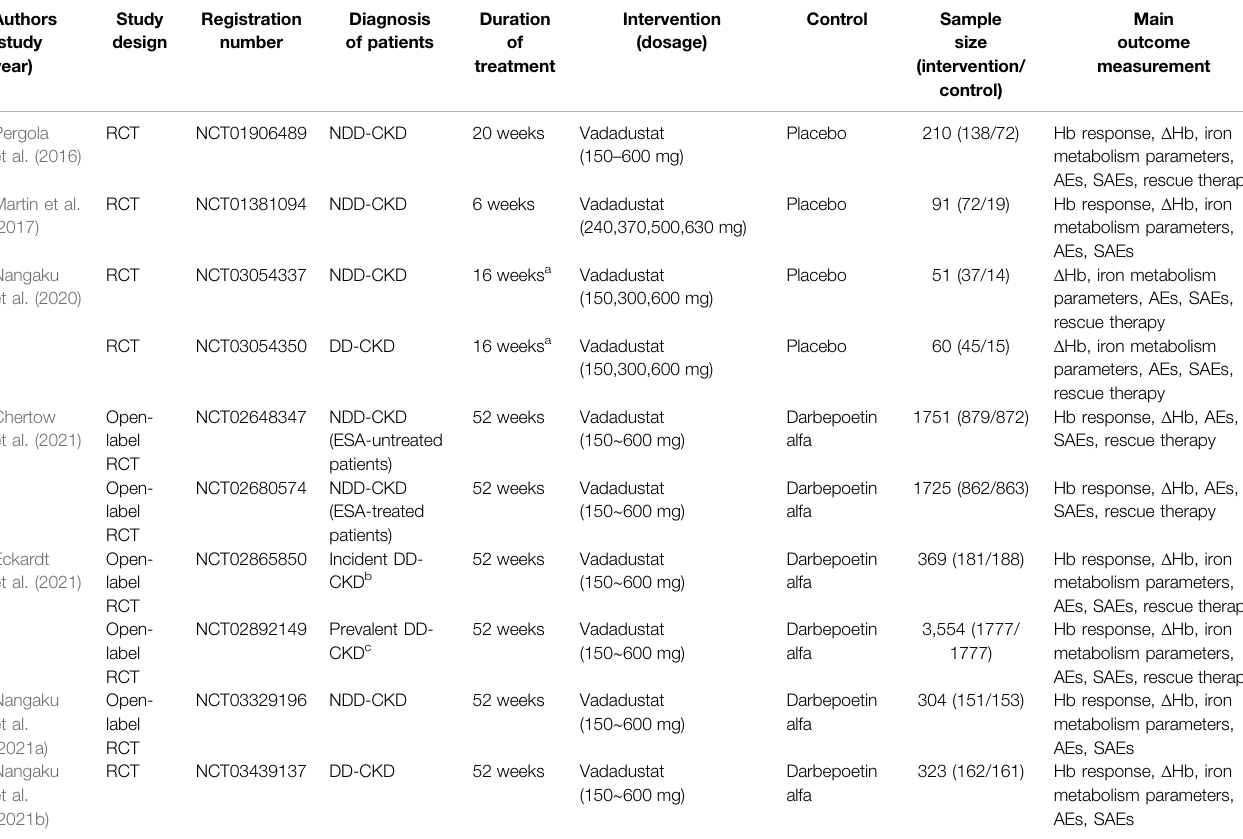
TABLE 1 | Characteristics of included